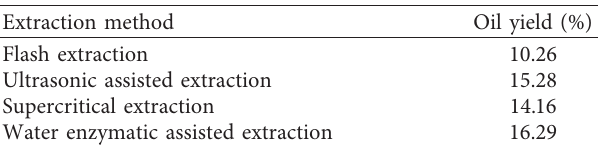
Table 9: Comparison of the best results of 4 extraction methods of palm seed